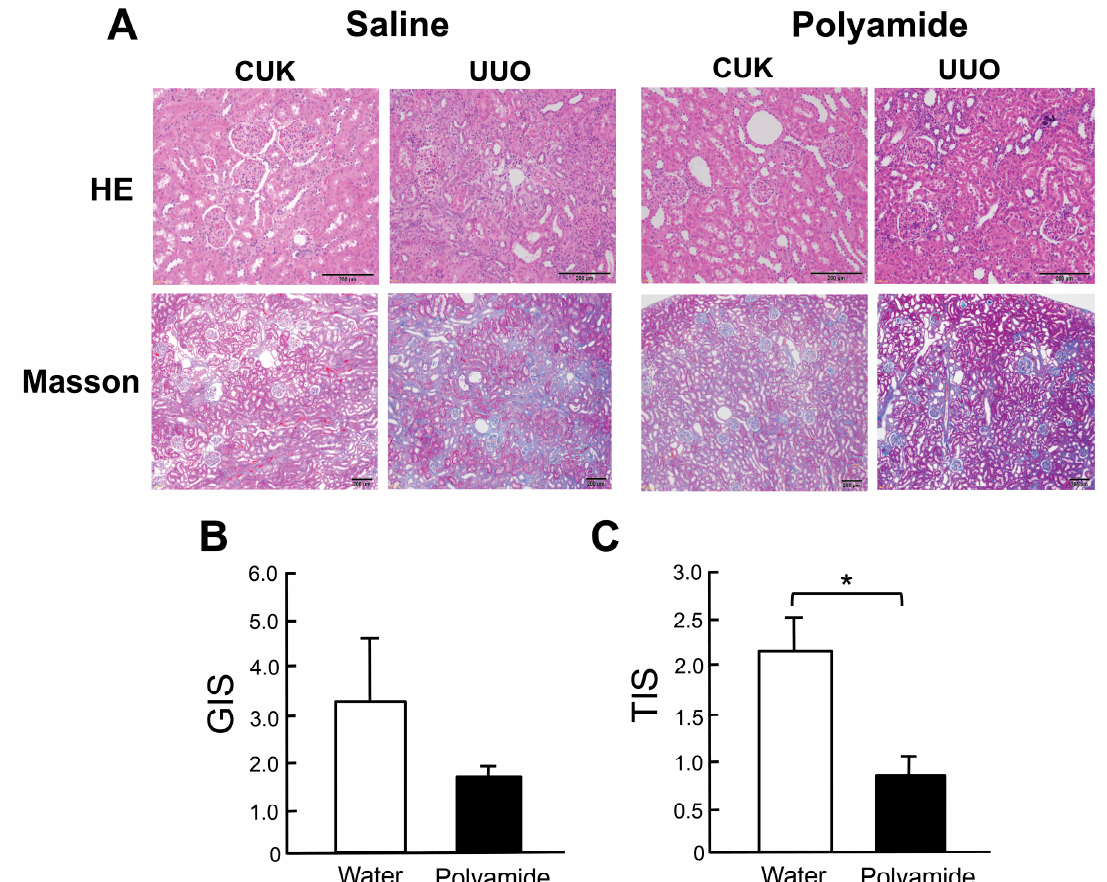
Figure 5. The effects of pyrrole-imidazole polyamide targeting human TGF- β 1 (Polyamide) on renal degeneration in unilateral urethral obstruction (UUO) kidney in marmosets. The left ureter was ligated, whereas, in sham-operated marmosets, the left ureter was not disturbed. The marmosets with UUO were intravenously injected with Polyamide (1 mg/kg/week) through the tail vein for four weeks from one week after the operation. Control marmosets with UUO were intravenously injected with the same amount of saline through the tail vein. ( A ) Paraffin-embedded sections of the removed renal cortex were stained with hematoxylin and eosin (HE) and Masson trichrome (Masson) in the contralateral unobstructed kidney (CUK) and UUO kidney. ( B ) Glomerular injury score (GIS). ( C ) Tubulointerstitial injury score (TIS). Data indicate the mean ± SEM ( n = 6). * p < 0.05 in the indicated columns. Bar = 50 µm.